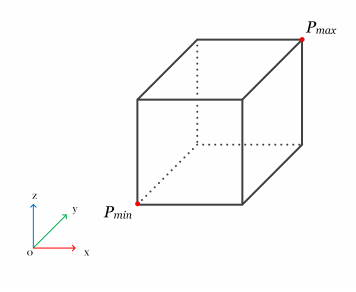
Figure 2: Voxel cell in 3D